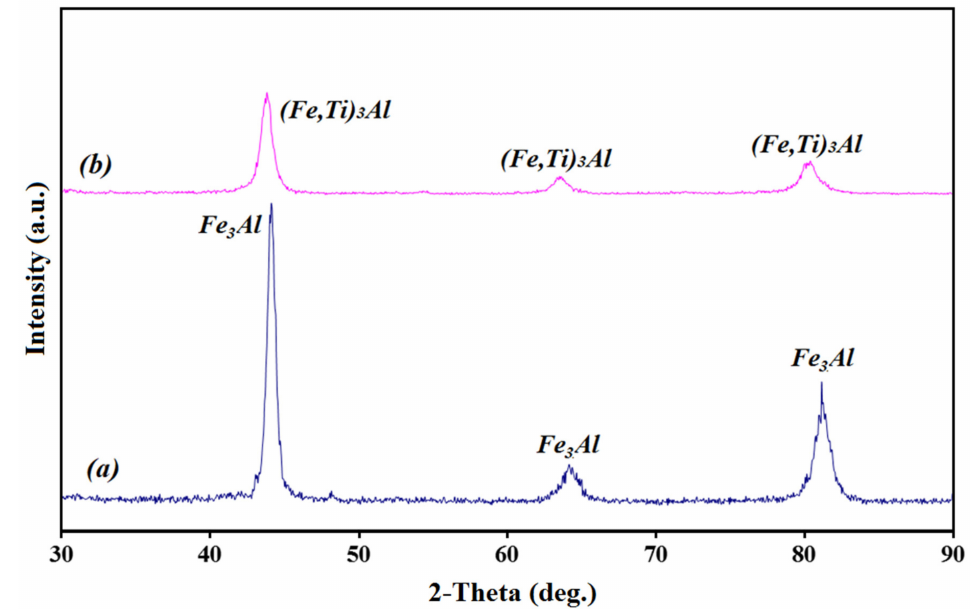
Figure 4. XRD patterns of powder mixtures after spark plasma sintering; ( a ) Fe 3 Al and ( b ) (Fe,Ti) 3 Al. In addition, EDS analysis was conducted on the bulk samples (after the SPS